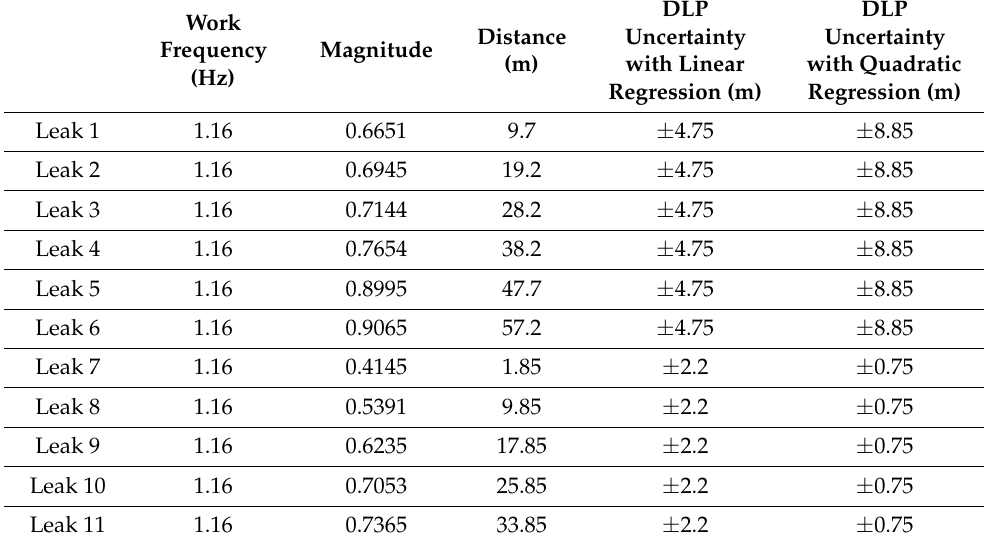
Table 1. Recovered leak positions and